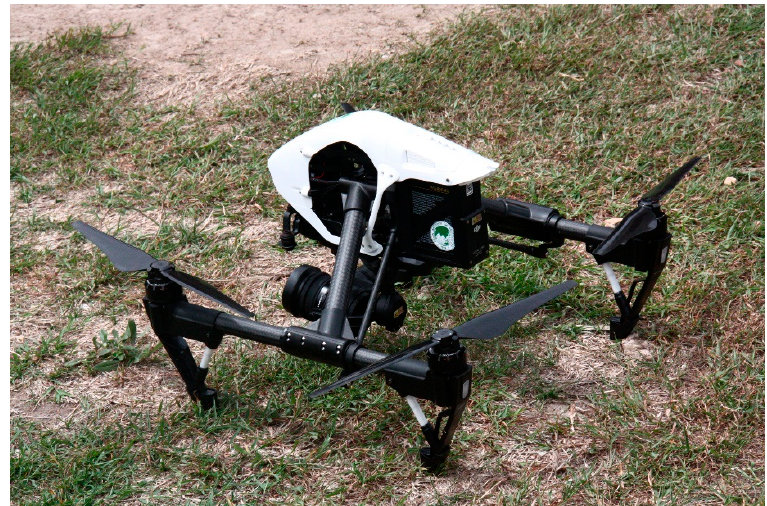
Figure 3. DJI Inspire 1 Pro and Inspire 1 RAW platforms designed to assist in aerial imaging.